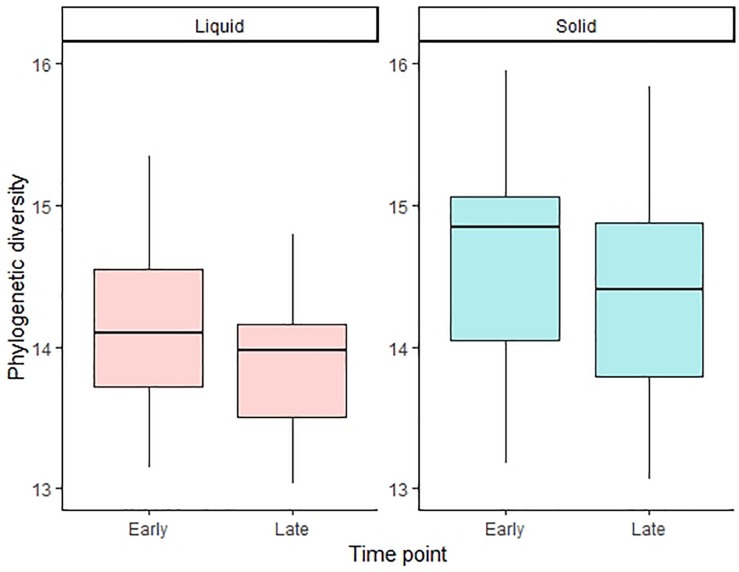
Alpha diversity calculated with the phylogenetic diversity index for the liquid and solid phase and for the early and late time point, respectively. The boxplots show the 25th, 50th, and 75th percentiles, with whiskers showing the extremes of the data.